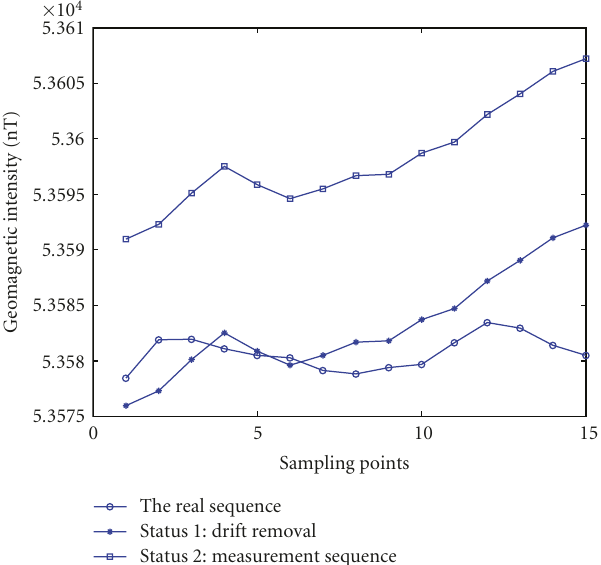
Figure 8: Geomagnetic map in local reference coordinates and the trajectories recorded by INS and GPS.